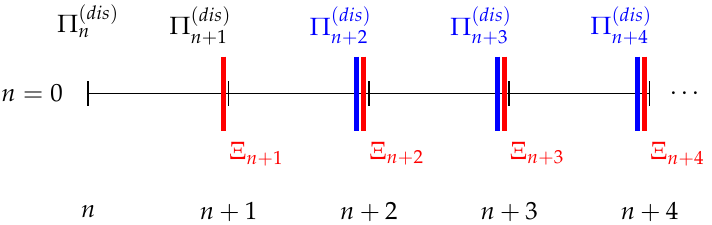
Figure 1. Time-line of the discrete time dynamical system. The simulation starts by assuming a ( dis ) distribution tariff Π n